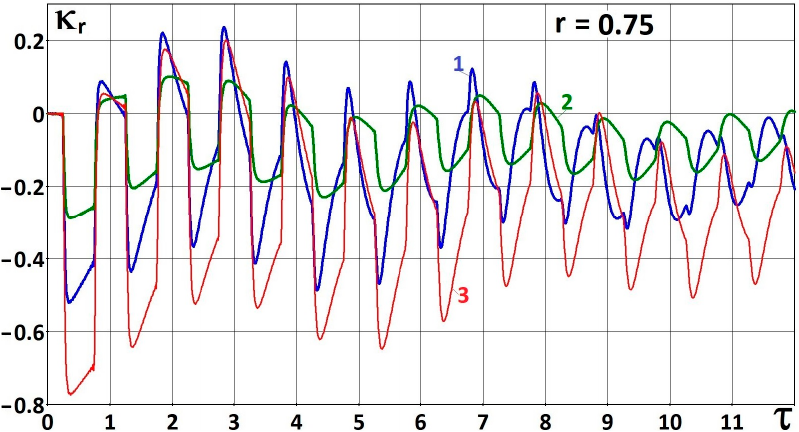
Figure 13. Time history of the relative radial stress at r = 0.75. Viscoelastic materials. FGM cylinder— curve 1; two-layer cylinder—curve 2; homogeneous cylinder—curve 3.